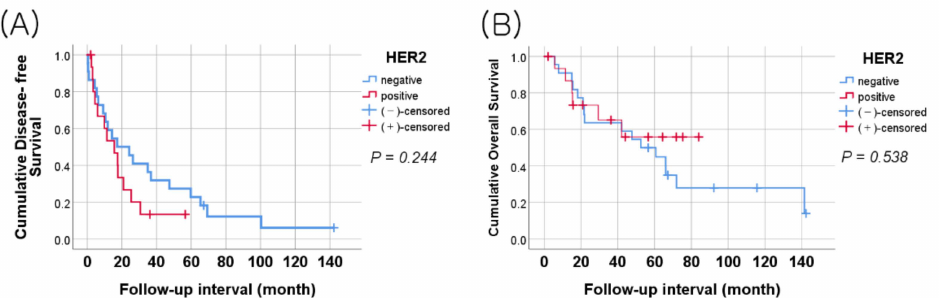
Figure 1. Kaplan–Meier survival curves. ( A ) Disease free survival (DFS) curve in 38 patients with HER2 expression. ( B ) Overall survival (OS) curve in 38 patients with HER2 expression. The HER2 status showed no statistically significant relationship with DFS or